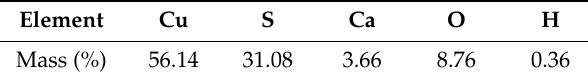
Table 2. Chemical analysis of the covellite